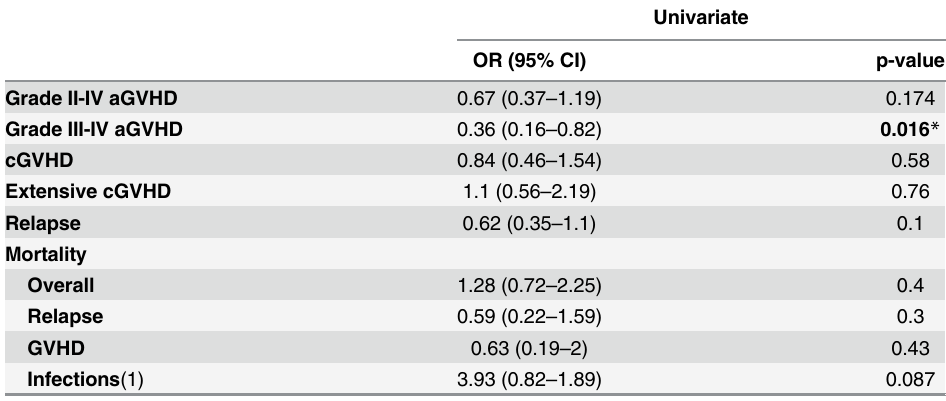
Table 2. Univariate analysis of the association between the presence of FOXP3 short alleles in the donor and the development of post-SCT complications.